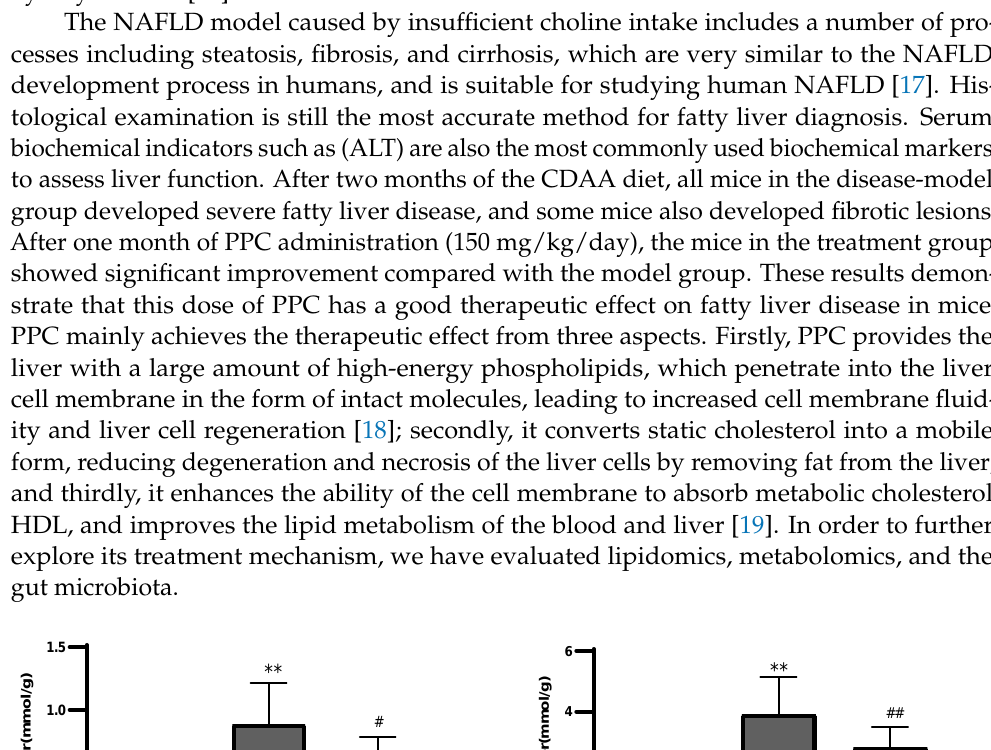
Table 1. NAS score of the CDAA, CSAA, and PPC groups.